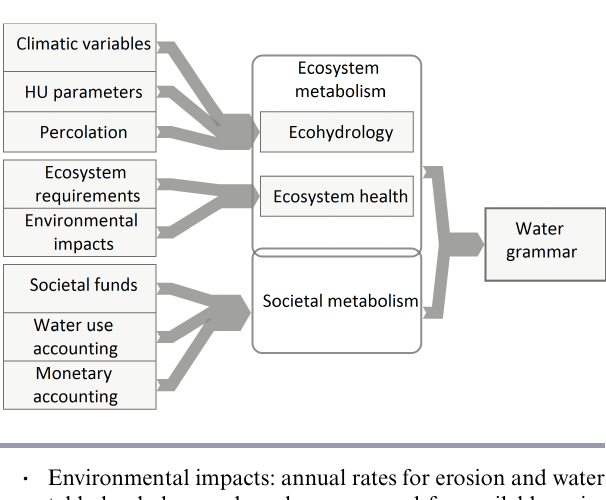
Table 4 . Relational indicators. Fig. 4 . Process